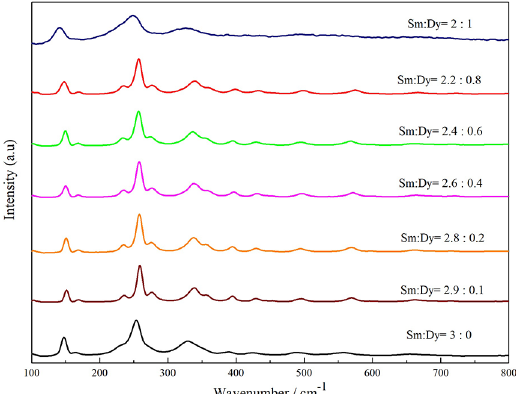
Dy Fe O with 3−x x 5 12